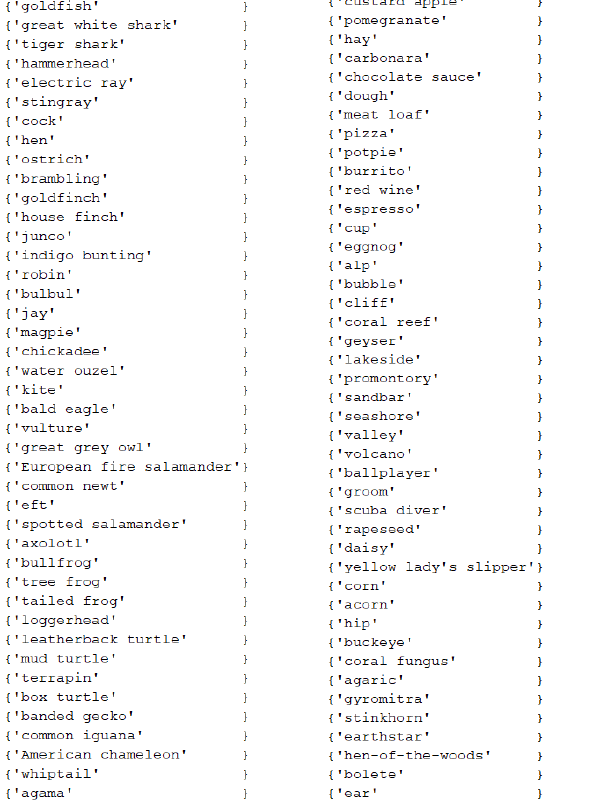
Fig. 3. A general scheme of fine-tuning a pretrained AlexNet CNN to perform classification on a new collection of images (origin: